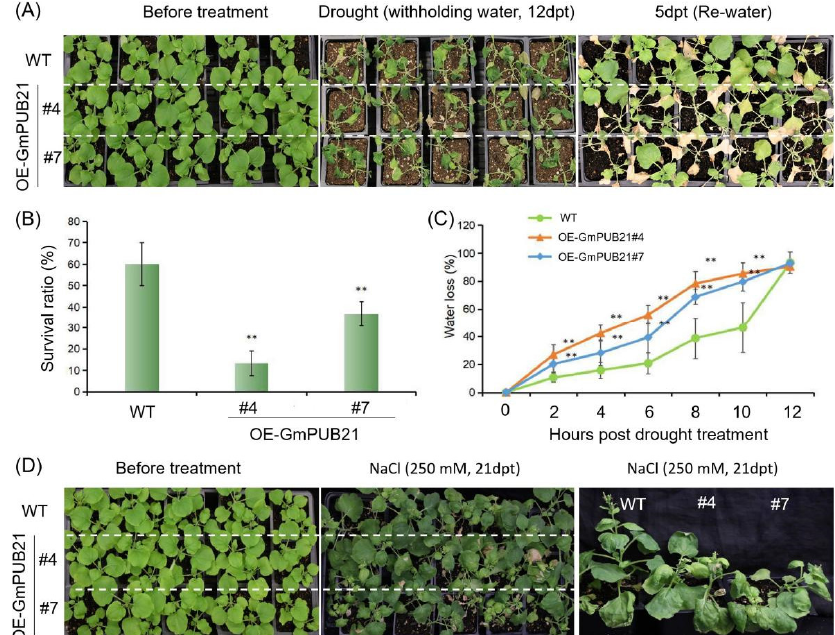
Figure 4. Overexpression of GmPUB21 tobacco plants is sensitive to drought and salinity stress. ( A ) 3-week-old seedlings were grown under normal conditions when exposed to drought stress by withdrawing the water for 12 days, and recovered for 5 days. ( B ) The survival rate was calculated as the percentage of plants that resumed growth 5 days after rewatering and survival rate values represent means ± SD ( n = 30). ( C ) Comparison of the water loss from detached rosette leaves of the WT and 35S:GmPUB21 plants at the time points indicated. Water loss was expressed as a percentage of the initial fresh weight. Data shown are the means ± SD of three independent experiments. Asterisks indicate statistically significant differences relative to WT (Student’s t -tests, ** p < 0.01). ( D ) 3-week-old seedlings of transgenic and WT plants undergo salinity stress (250 mM NaCl for 21 days) and the phenotype differences were observed in transgenic and wild-type plants after salt treatment by 250 mM NaCl for 21 days, dpt = days for post treatment. The experiments were repeated three times and similar results were obtained.